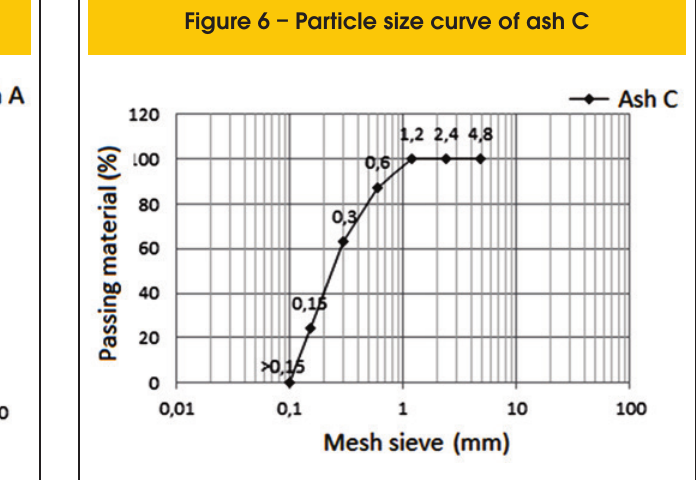
Figure 6 – Particle size curve of ash